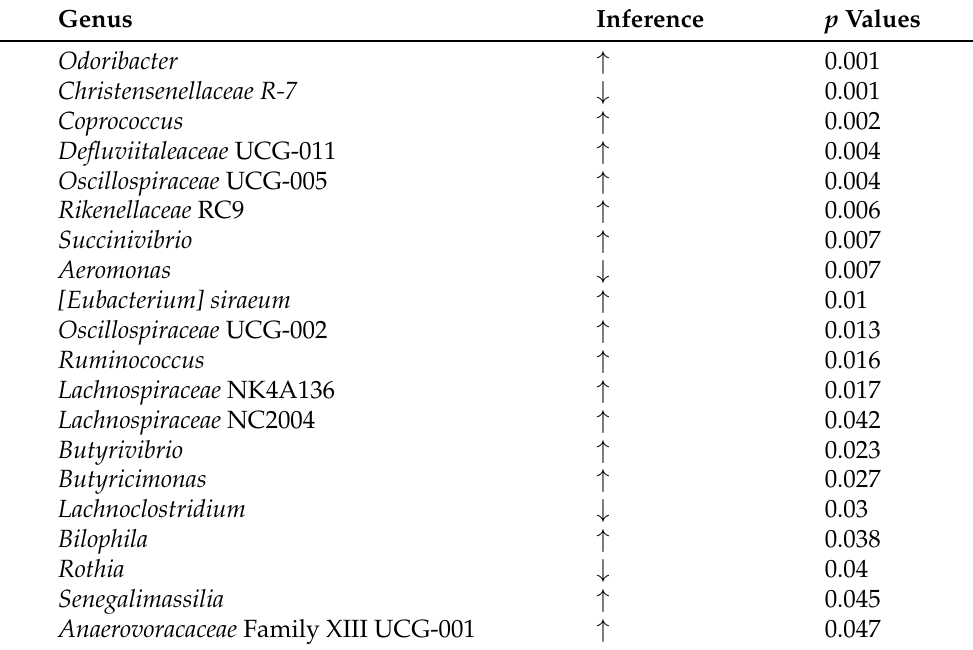
Table 1. Comparison between gut bacteria in drinkers and nondrinkers of the rice beverage in the Tiwa community. Upward arrows indicate an increase in drinkers vs. nondrinkers and vice